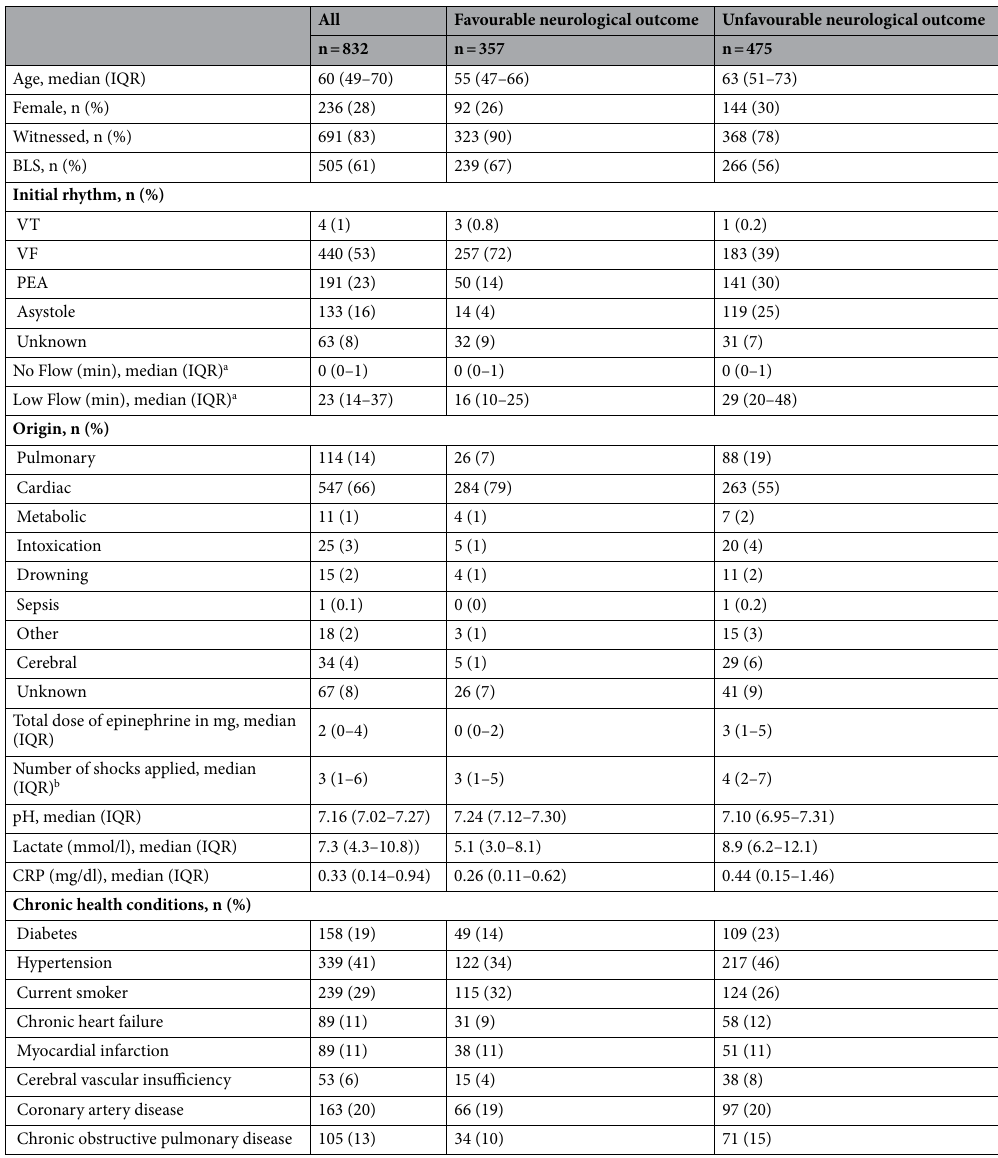
basic life support performed by bystanders, CRP c-reactive protein, PEA pulseless electrical activity, IQR inter quartile range, VF ventricular fibrillation, VT pulseless ventricular tachycardia. a Data only for witnessed available. b Data only from patients receiving at least one